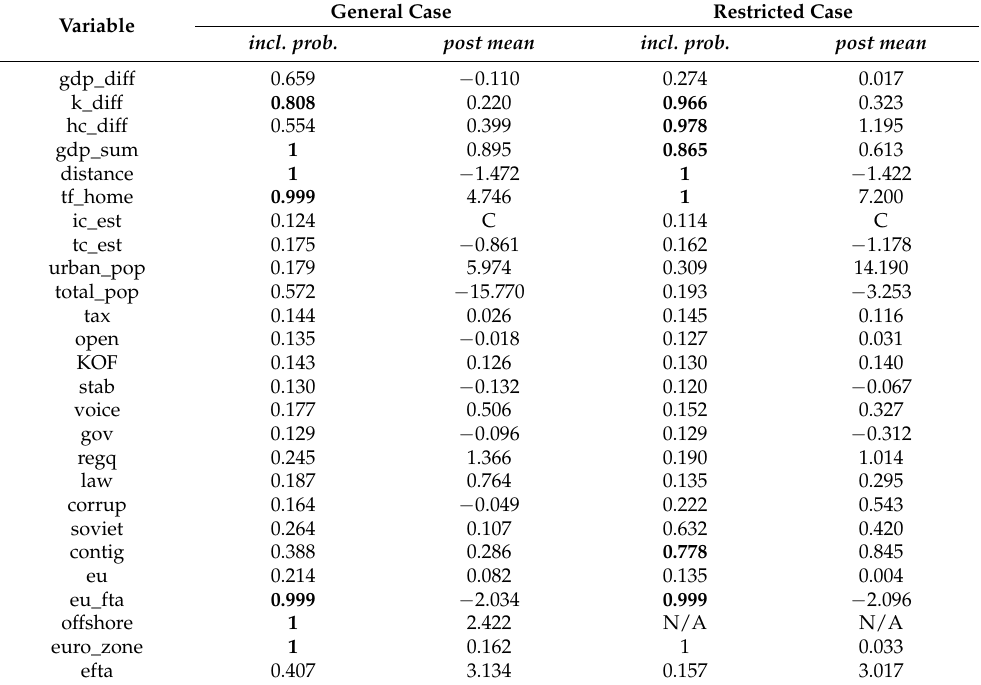
Table A5. Determinants of inward FDI in Estonia (2004–2017).